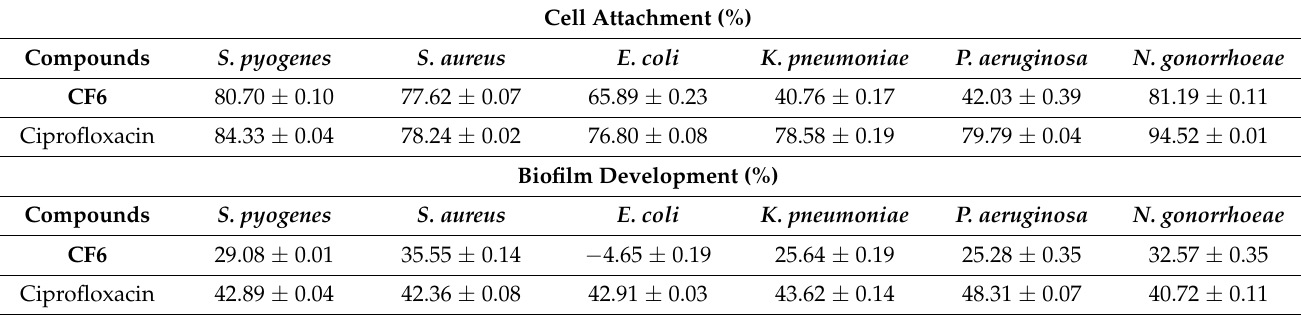
Table 3. Inhibition of cell attachment and biofilm development (at respective MIC values) on selected pathogens following exposure to CF6 .